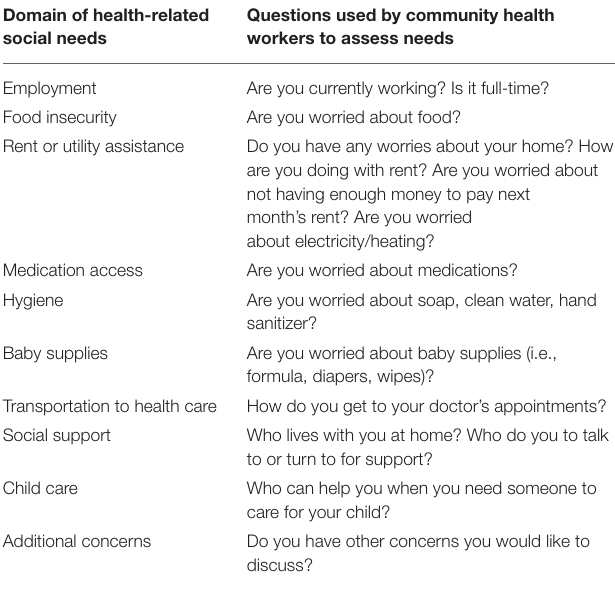
TABLE 2 | 10-item screening domains for social determinants of health related to